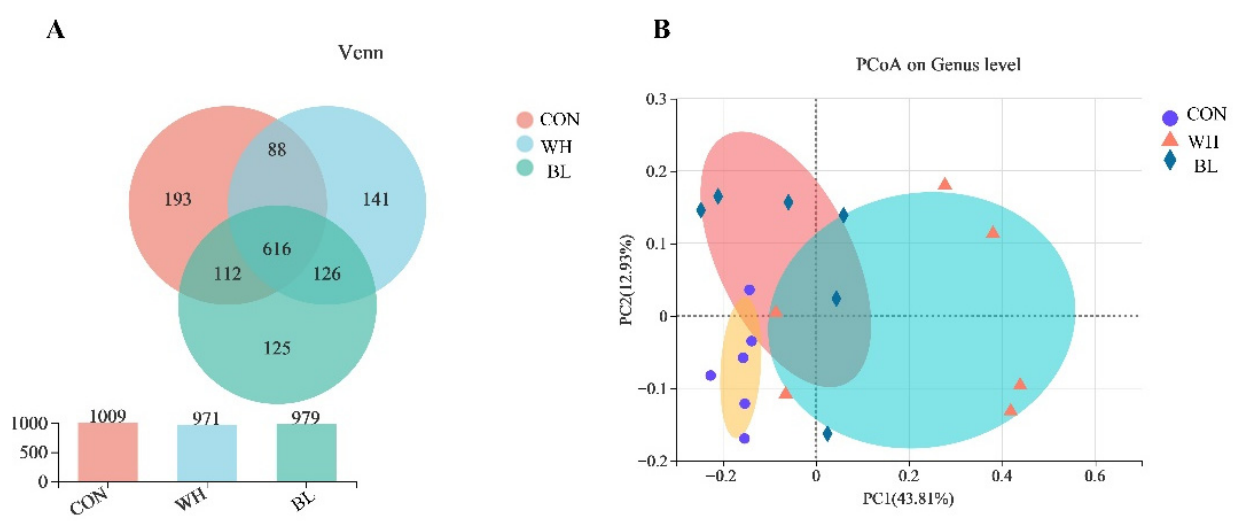
Figure 1. ( A ) Effects of the partial substitution of corn by wheat or barley on the OTU of fecal microflora in growing pigs. ( B ) Principal coordinate analysis (PCoA) of the fecal microbial composition